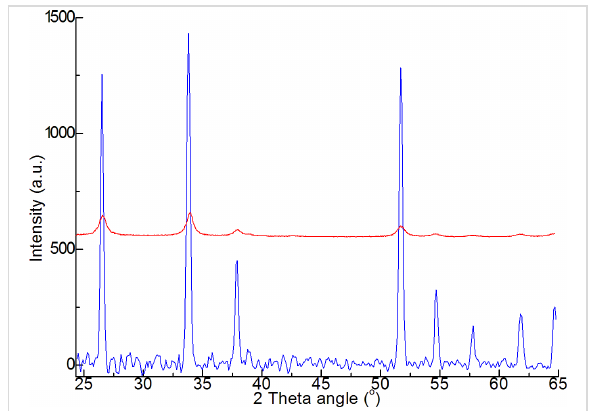
Figure 4: Experimental diffractograms of SnO2 nanowire (blue) and SnO2 nanopowder